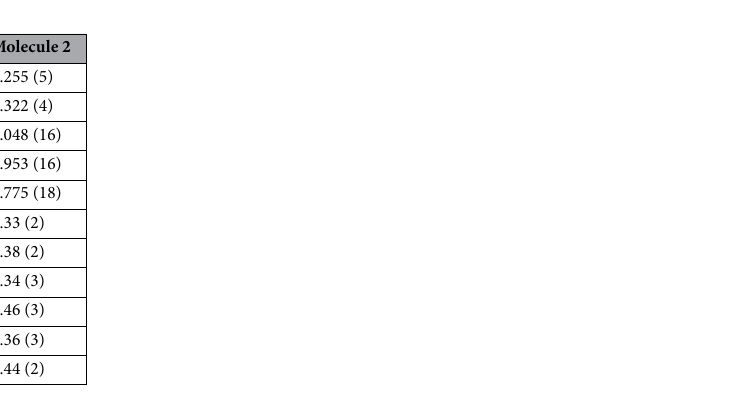
Figure 1. ORTEP diagram of the two independent molecules of platin complex Pt (TSC) Cl; ellipsoids are at the 50% probability level.